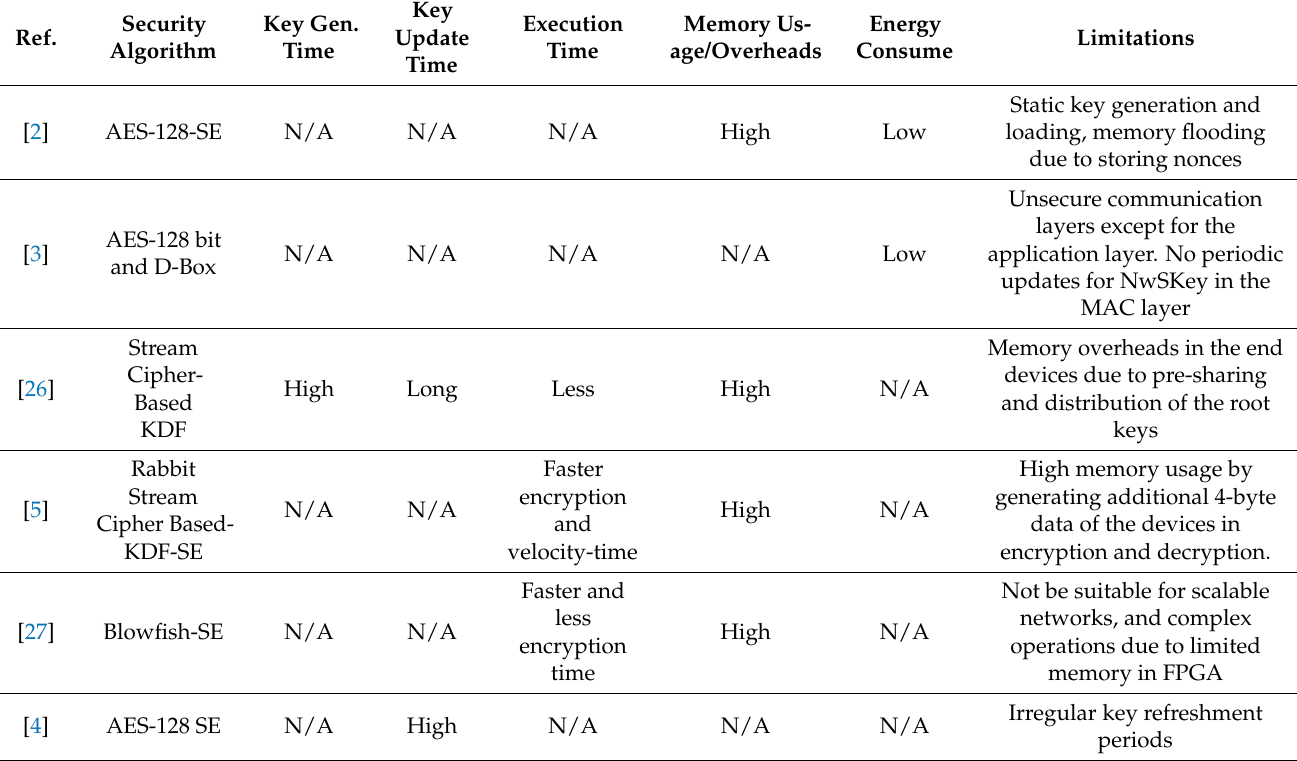
Table 2. Summary of Security Algorithms and Analysis in